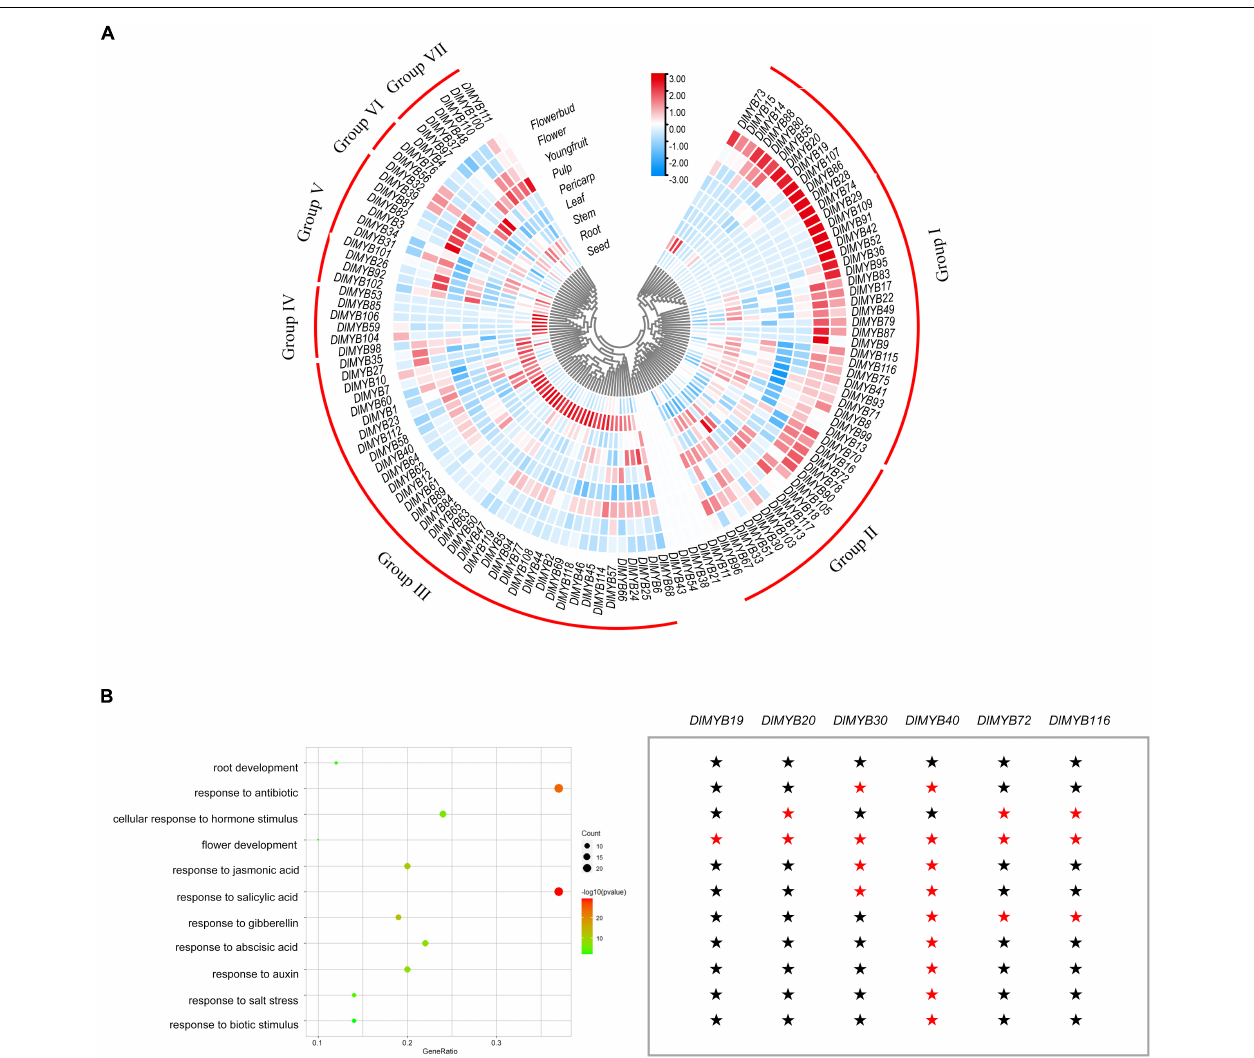
FIGURE 7 | Tissue-specific expression and GO enrichment analysis of DlMYB genes. (A) The expression levels of DlMYB genes in nine tissues were classified into groups I–VII. Different colors indicate log2 transformed expression levels, with red indicating high expression levels and blue indicating low expression levels. (B) Some DlMYB genes were classified as related to stress response, development, and hormones. The size of the circle indicates the number of DlMYB genes, and the color gradient indicates the size of the P -value. Six DlMYB genes are categorized into “flower development” function. A red pentagram represents that the gene is relevant, while a black pentagram indicates that the gene is not involved in the